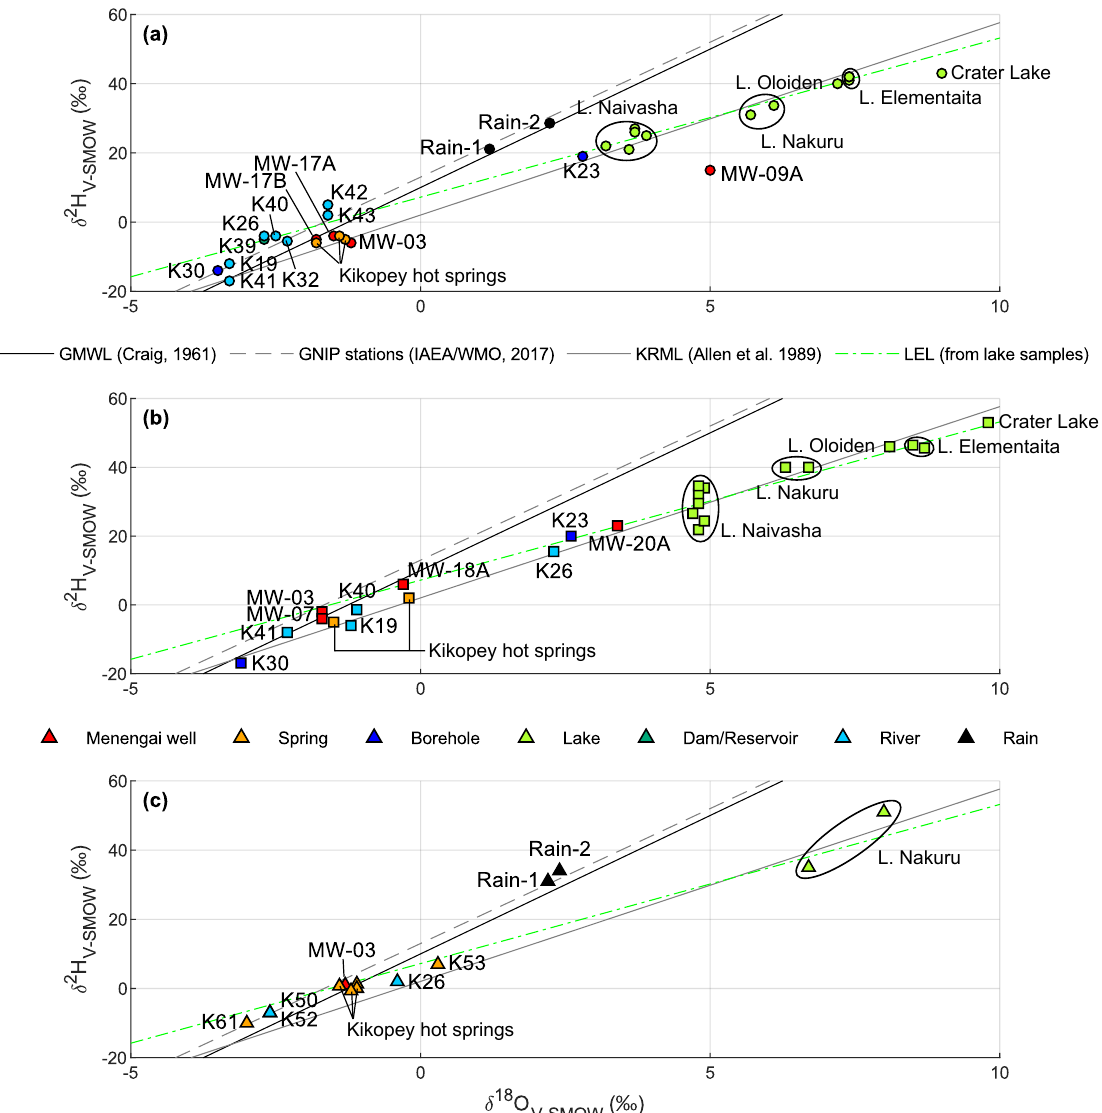
Figure 7. δ 18 O and δ 2 H data plots from the study area. ( a ) Sampling from June / July 2016; ( b ) sampling from January 2017; ( c ) sampling from June 2017. GMWL: Global Meteoric Water Line [64]. GNIP: Global Network of Isotopes in Precipitation data from Kericho and Muguga stations [65]. KRML: Kenya Rift Meteoric Line [8]. LEL: Lake Evaporation Line fitted by least square regression to all lake data collected by the